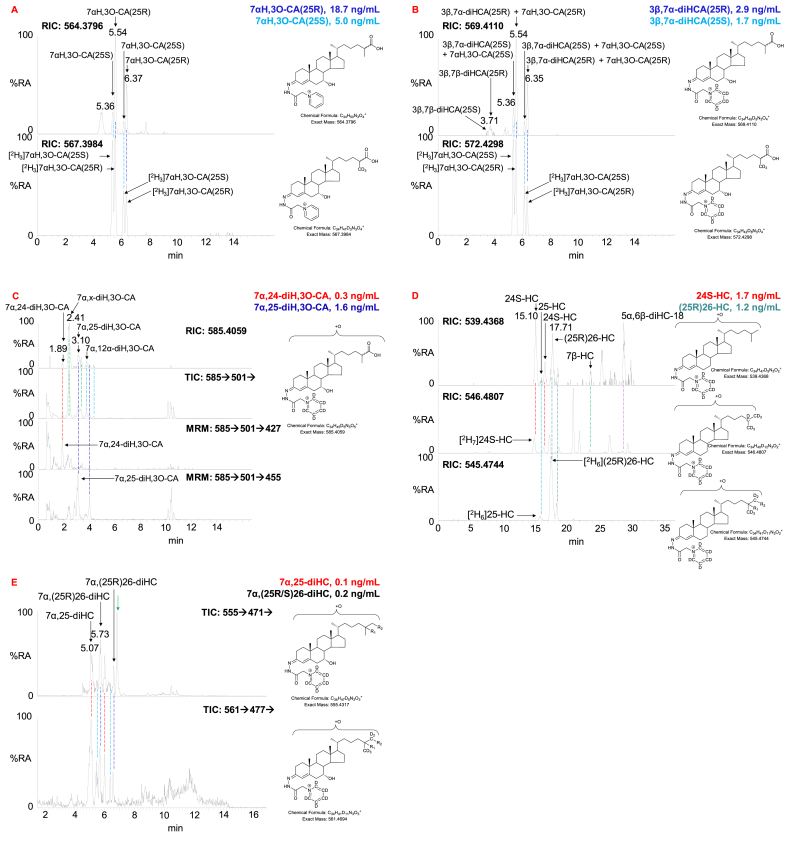
LC-MS separation of GP-derivatised cholestenoic acids, and mono- and dihydroxycholesterols in CSF. (A) RIC for the [M]+ ions of (upper panel) 7αH,3O-CA(25R/S) (564.3796 ± 5 ppm) found in CSF, and (lower panel) [2H3]7αH,3O-CA(25R/S) (567.3984 ± 5 ppm). (B) RIC for the [M]+ ions of (upper panel) 7αH,3O-CA(25R/S) + 3β,7α-diHCA(25R/S) (569.4110 ± 5 ppm) found in CSF, and (lower panel) [2H3]7αH,3O-CA(25R/S) (572.4298 ± 5 ppm). In (A) the derivatisation agent was [2H0]GP and in (B) [2H5]GP. (C) RIC for the [M]+ ions of diH,3O-CA isomers (585.4059 ± 5 ppm) found in CSF (upper panel), note the triHCA equivalents are absent. TIC for the MS3 fragmentation (585.4 → 501.3→) for diH,3O-CA isomers (2nd panel). MRM (585.4 → 501.3→427.3) targeting 7α,24-diH,3O-CA (3rd panel), and MRM (585.4 → 501.3→455.3) targeting 7α,25-diH,3O-CA (bottom panel). See Supplemental Figures S4P & S4Q for relevant fragmentation schemes. Chromatograms in (A–C) are from non-hydrolysed CSF. (D) RIC of the [M]+ ions of monohydroxycholesterols (539.4368 ± 3 ppm) found in CSF (upper panel). RIC (546.4807 ± 3 ppm) for [2H7]24R/S-HC, [2H7]7β-HC, [2H7]7α-HC and dehydrated [2H7]5α,6β-diHC (central panel). RIC (545.4744 ± 3 ppm) for [2H6]25-HC and [2H6](25R)26-HC (lower panel). (E) TIC for the MS3 fragmentations (555.4 → 471.4→) of 7α,25-diHC and 7α,(25R/S)26-diHC found in CSF (upper panel) and for the fragmentations (561.5 → 477.4→) of [2H6]7α,25-diHC and [2H6]7α,(25R/S)26-diHC. Chromatograms (D & E) are for hydrolysed CSF. Coloured dashed lines indicate the coincidence of peaks of the same oxysterol. All chromatograms were recorded over a 17 min gradient.